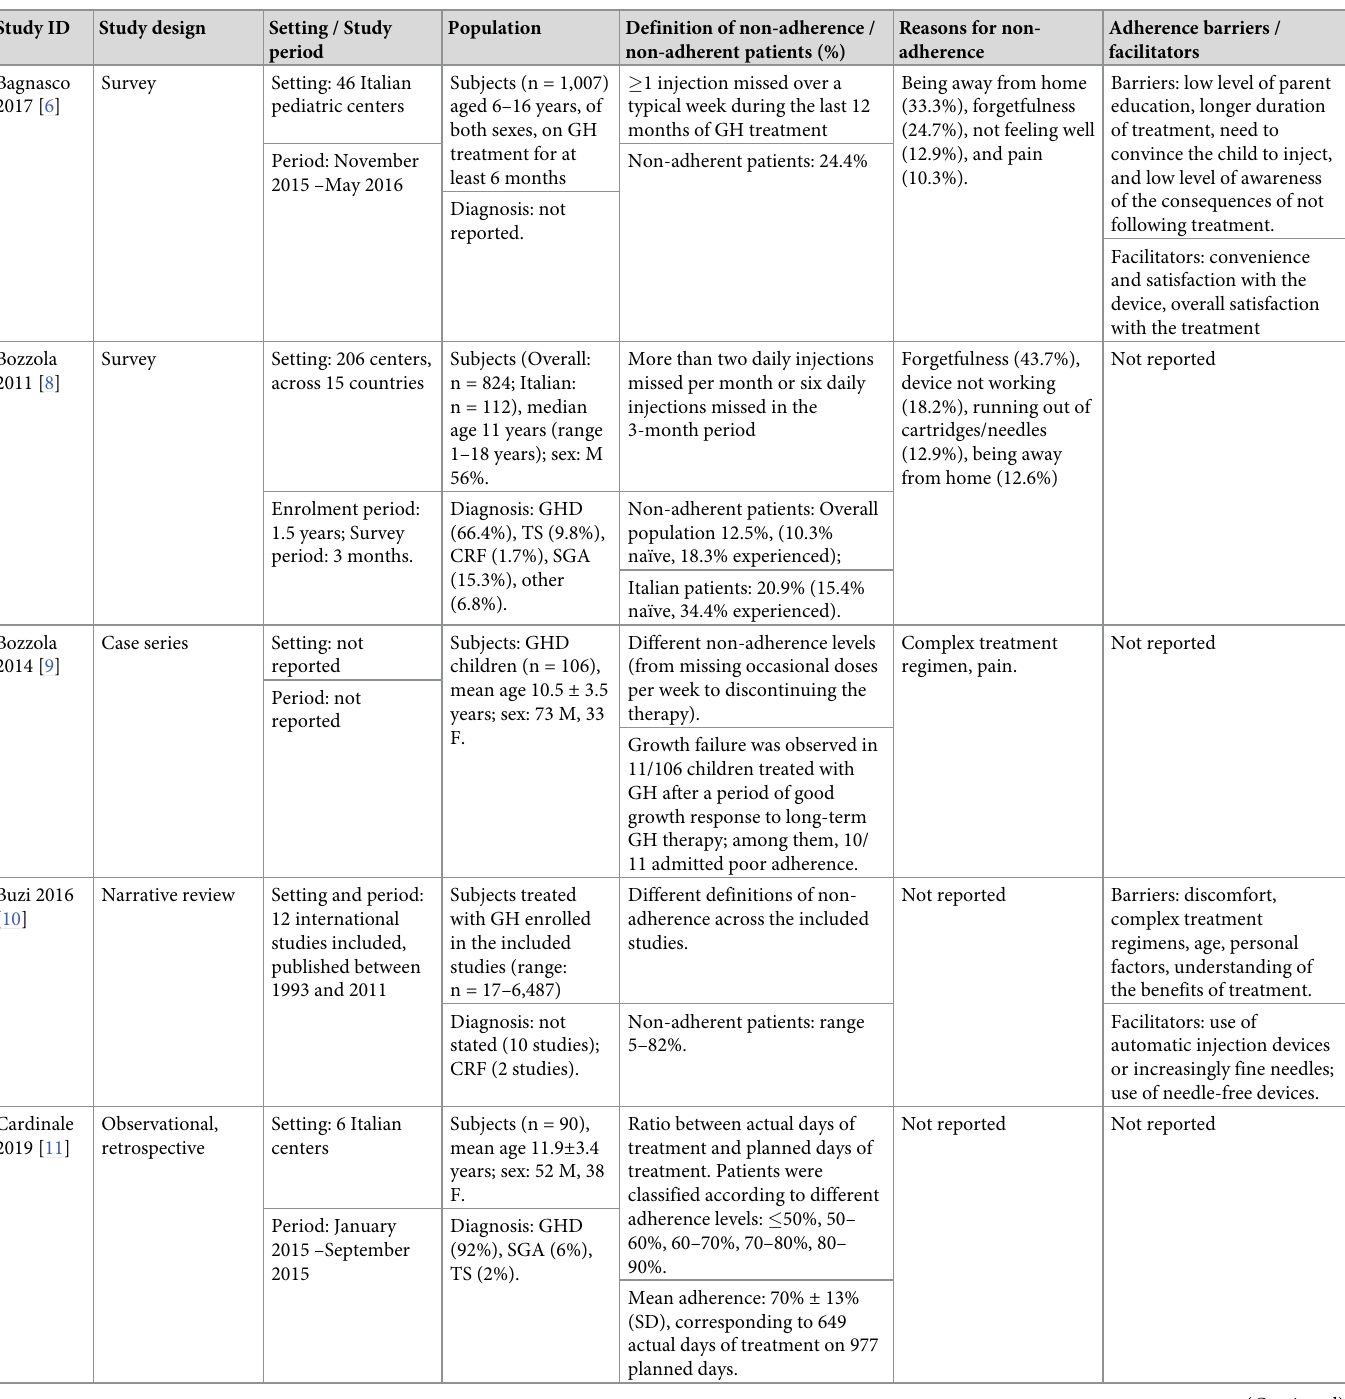
Table 3. Characteristics of included studies for